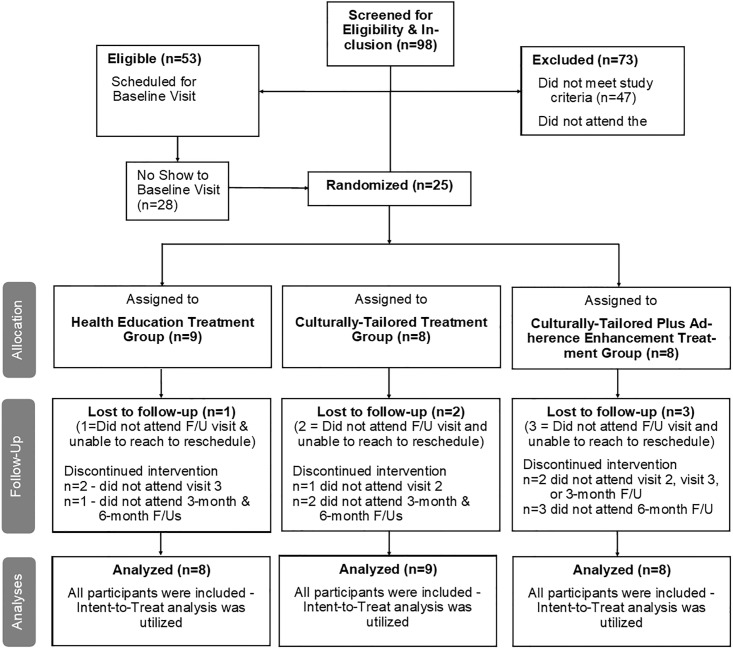
Participant flow diagram.